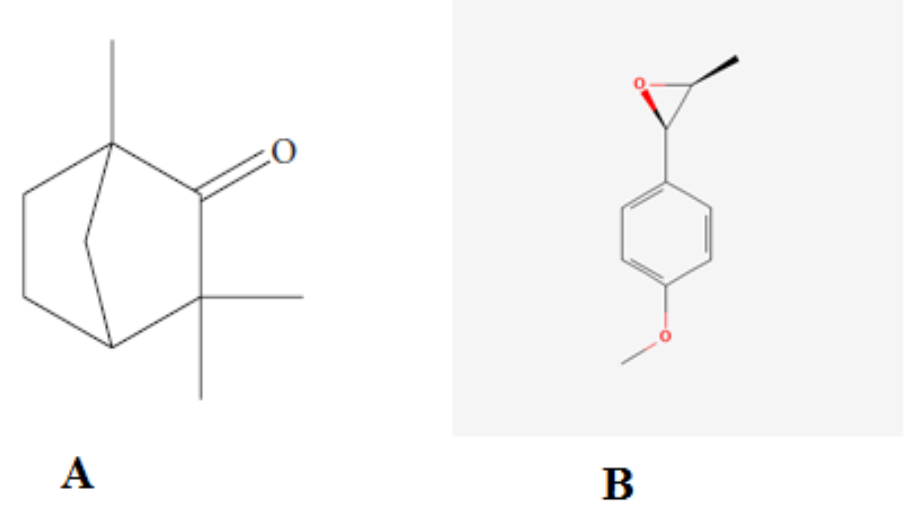
Figure 1. Molecular structures of ( A ) fenchone (FCO) and ( B ) trans -anethole (TOH). Trans -anethole (TOH; chemical structure: Figure 1B) is a monoterpene present in the essential oils of a variety of plants, including fennel fruits [14]. The most prevalent component in the essential oils of fennel fruits, according to a GC-MS analysis [13], is TOH. For the determination of TOH in various plant extracts, essential oils, and biological samples, various analytical approaches such as high-performance liquid chromatography (HPLC) [15–19], GC-MS [20–26], nuclear magnetic resonance spectroscopy [23],